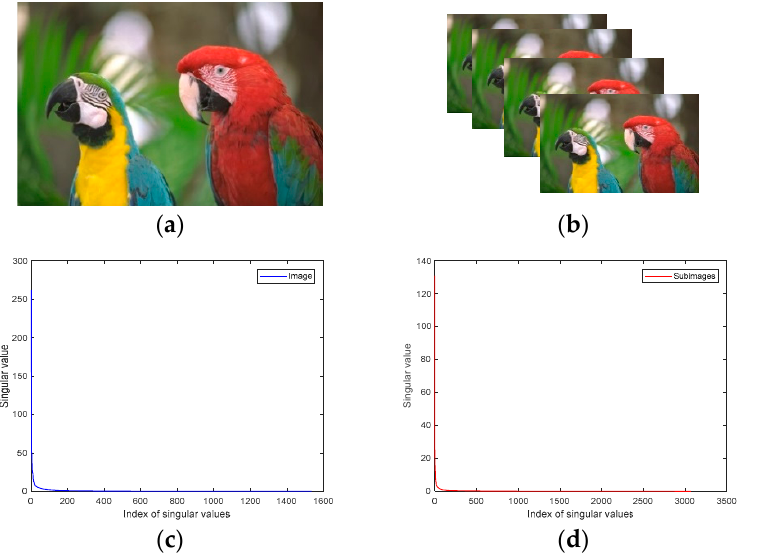
Figure 1. Color image and its singular values. ( a ) Color Image kodim23 denoted by X ∈ R 512 × 768 × 3 ; ( b ) Color sub-image set denoted by X s ∈ R 256 × 384 × 12 ; ( c ) the singular values of bcirc ( X ) ; ( d ) the singular values of bcirc ( X s ) .